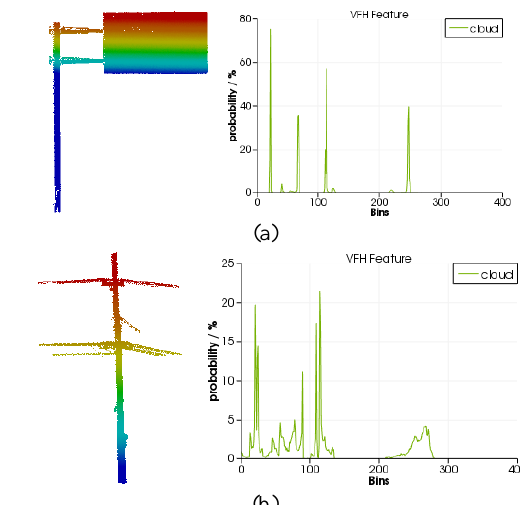
Figure. 6. The VFHs of different kinds of objects: (a) the VFH of traffic sign, (b) the VFH of utility